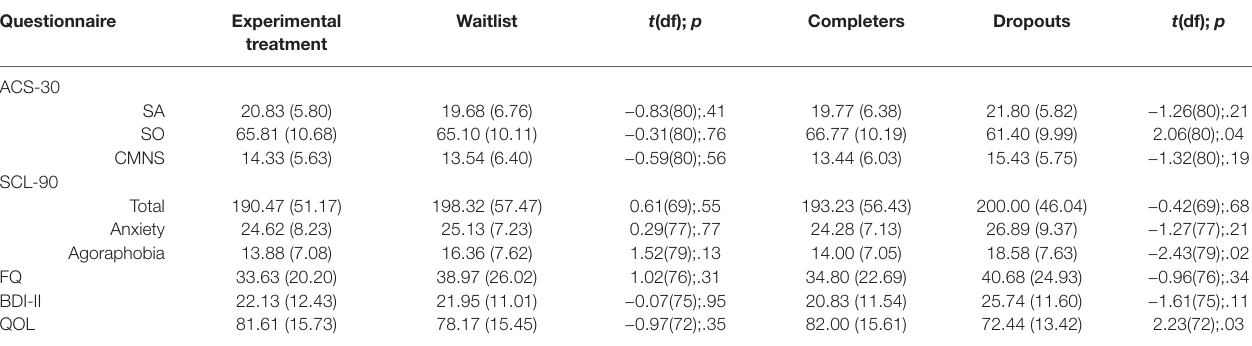
TABLE 3 | Patients’ baseline characteristics: observed means (SD) at t 1. Questionnaire Experimental